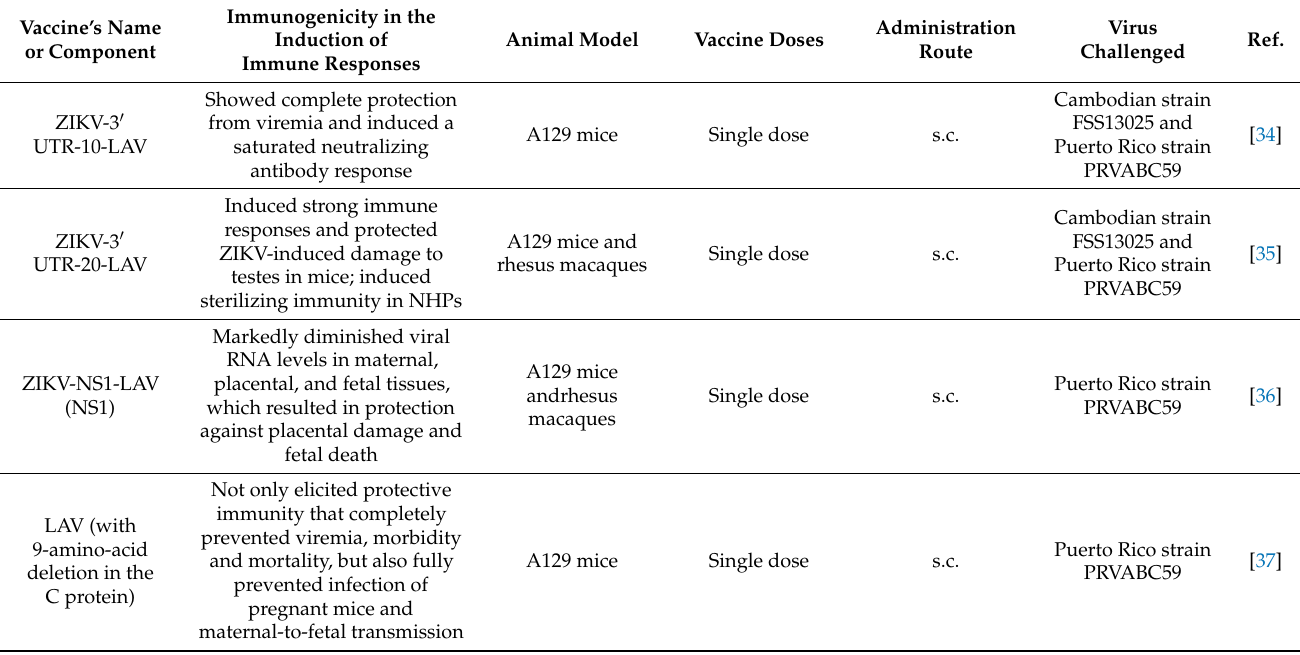
Table 3. Live-attenuated vaccines against ZIKV